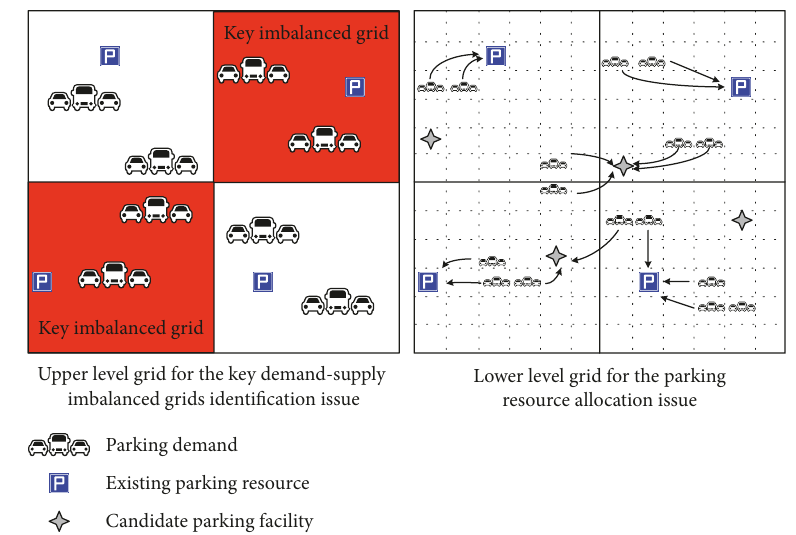
Figure 2: Two-level grid model.